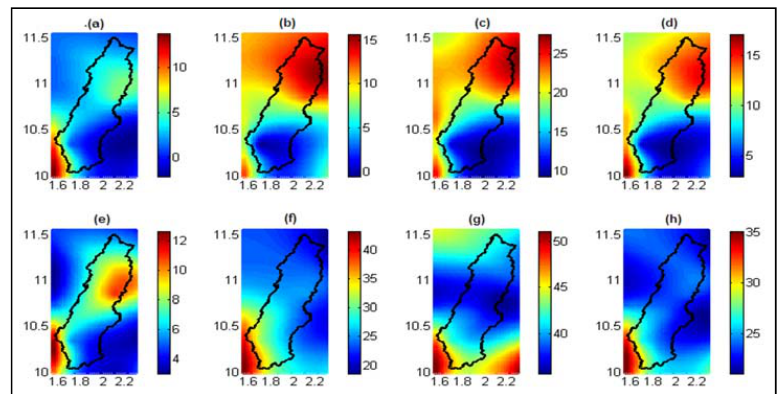
Figure 11 . Changes in the maximum precipitation amounts during 24 consecutive hours (%) Figure 11. Changes in the maximum precipitation amounts during 24 consecutive hours (%)